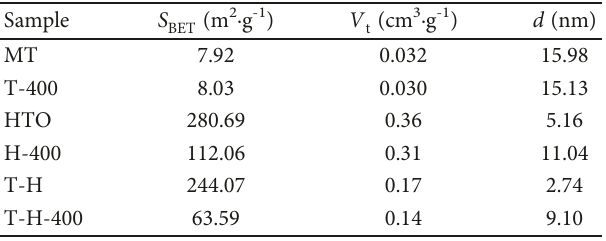
Table 2: Speci fi c surface area ( S Sample